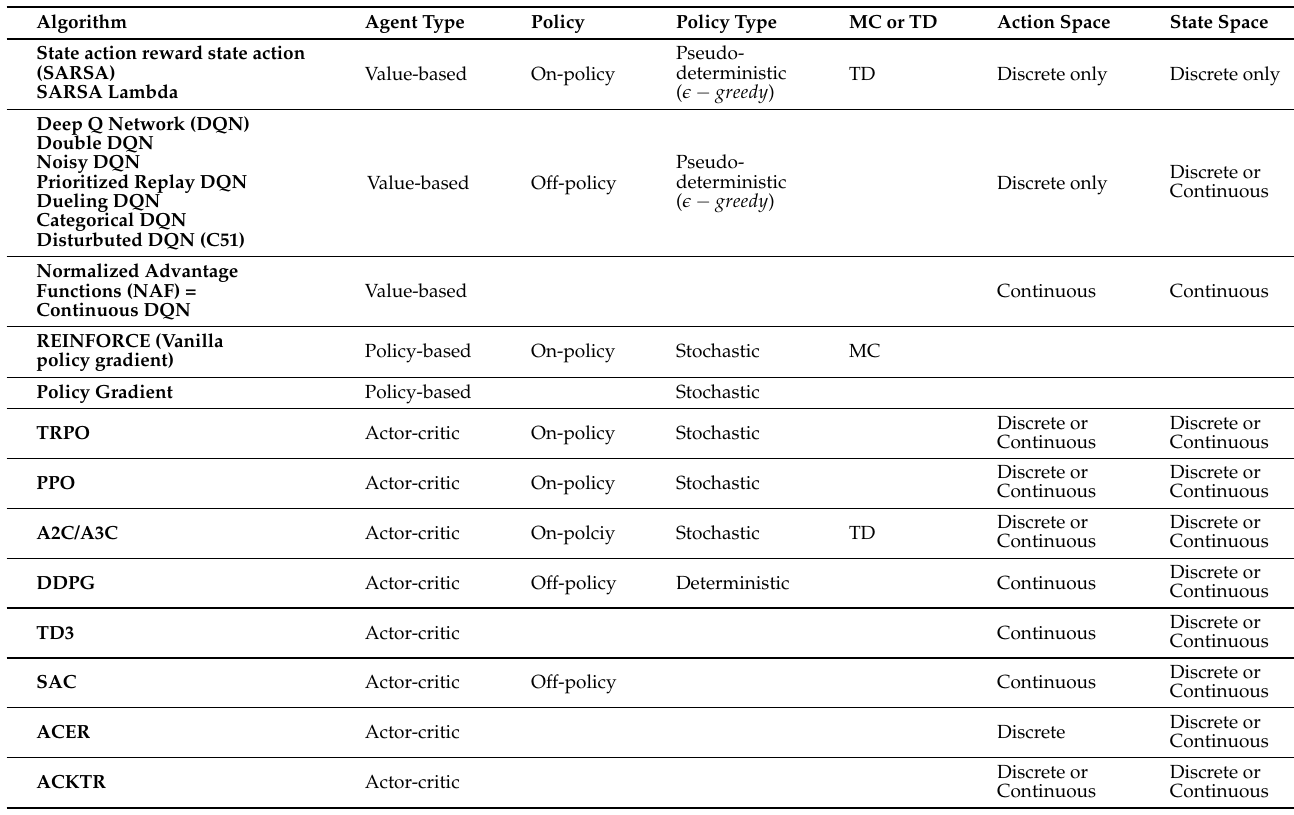
Table 1. Table summary of model-free RL